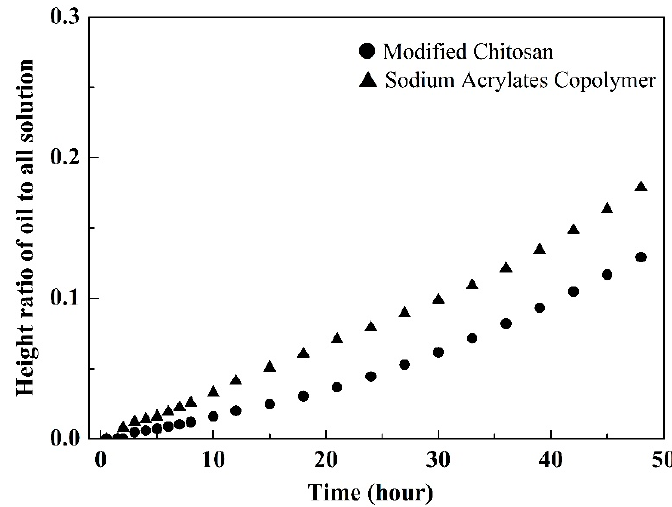
Figure 9. Emulsion stability test for different emulsifiers.